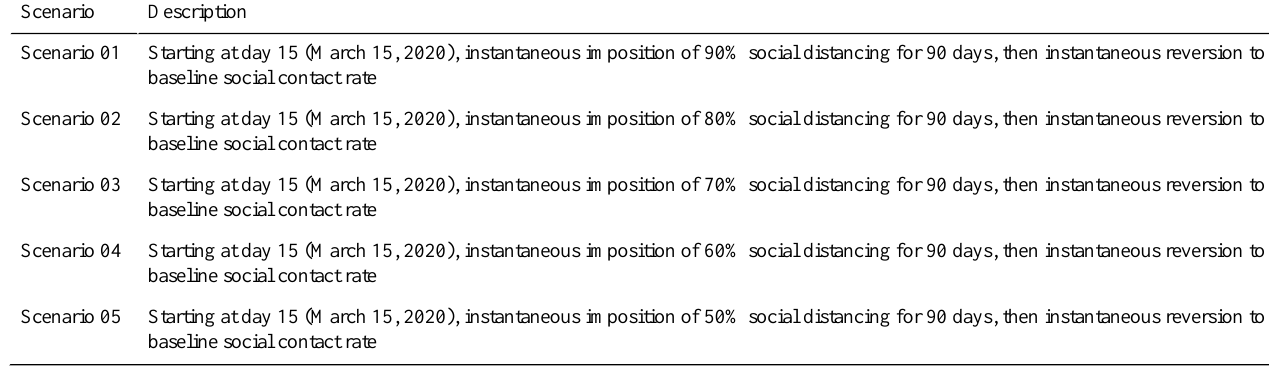
Table 2. Scenarios modeled for March 30, 2020.